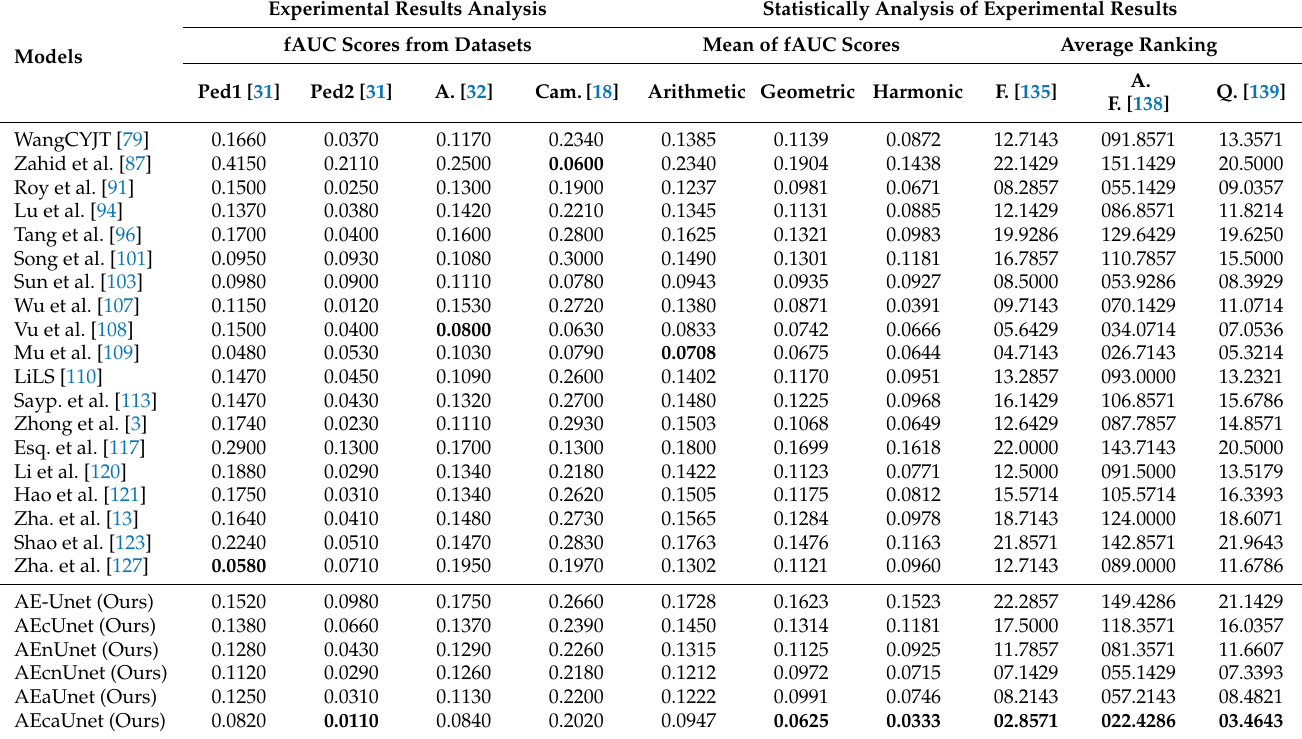
Table 9. Multiple comparison test for G 4 using fAUC. Column-wise the best numerical result is shown in bold .